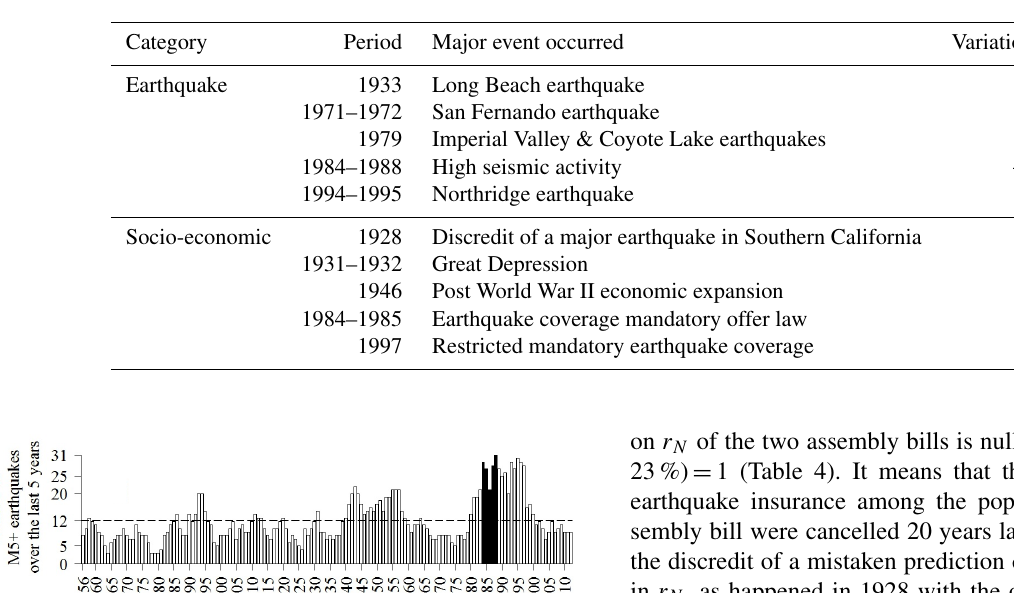
Table 4. Events expected to have significantly modified the homeowners’ risk perception through the subjective annual occurrence probabil- ity. V N represents the variation compared to the previous year, with the sign “ + ” for an increase and “ − ” for a decrease.